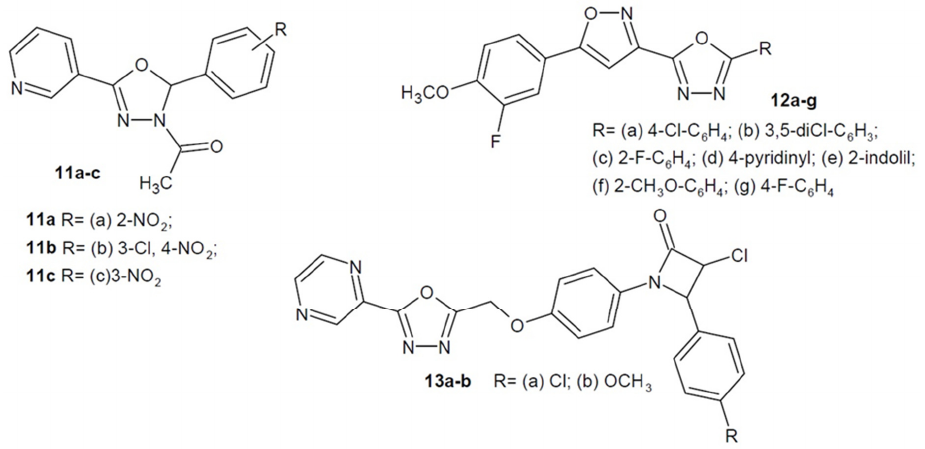
Figure 6. Aryl and/or heteroaryl 1,3,4-oxadiazole derivatives with antibacterial activity (part 2). Also among heteroaryl bi- or tricyclic rings fused directly to 1,3,4-oxadiazole, com- pounds with antibacterial activity can be